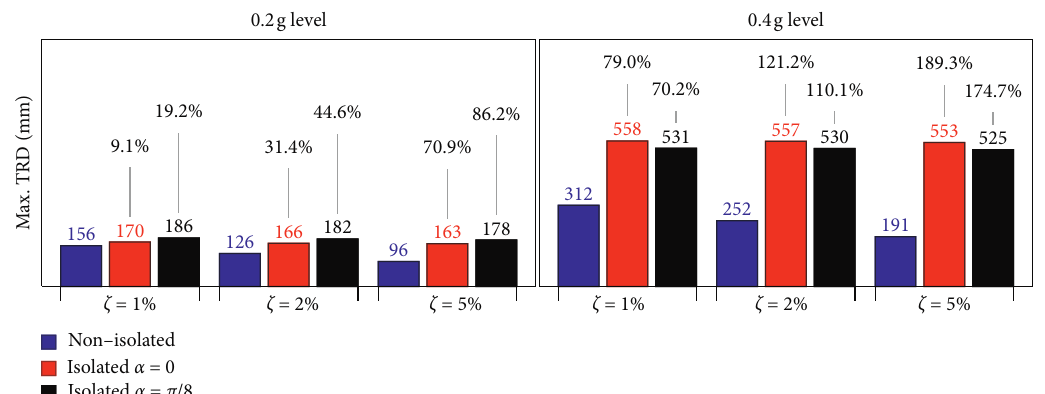
Figure 19: Maximum top relative displacement (TRD) of the nonisolated and isolated system and their change under different parameters of ζ and α at two seismic qualification